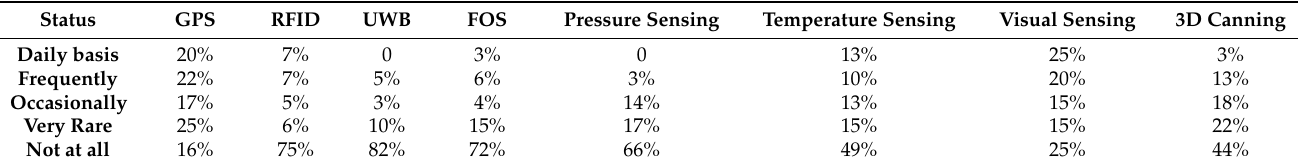
Table 2. Current status of various sensing technologies in building construction.